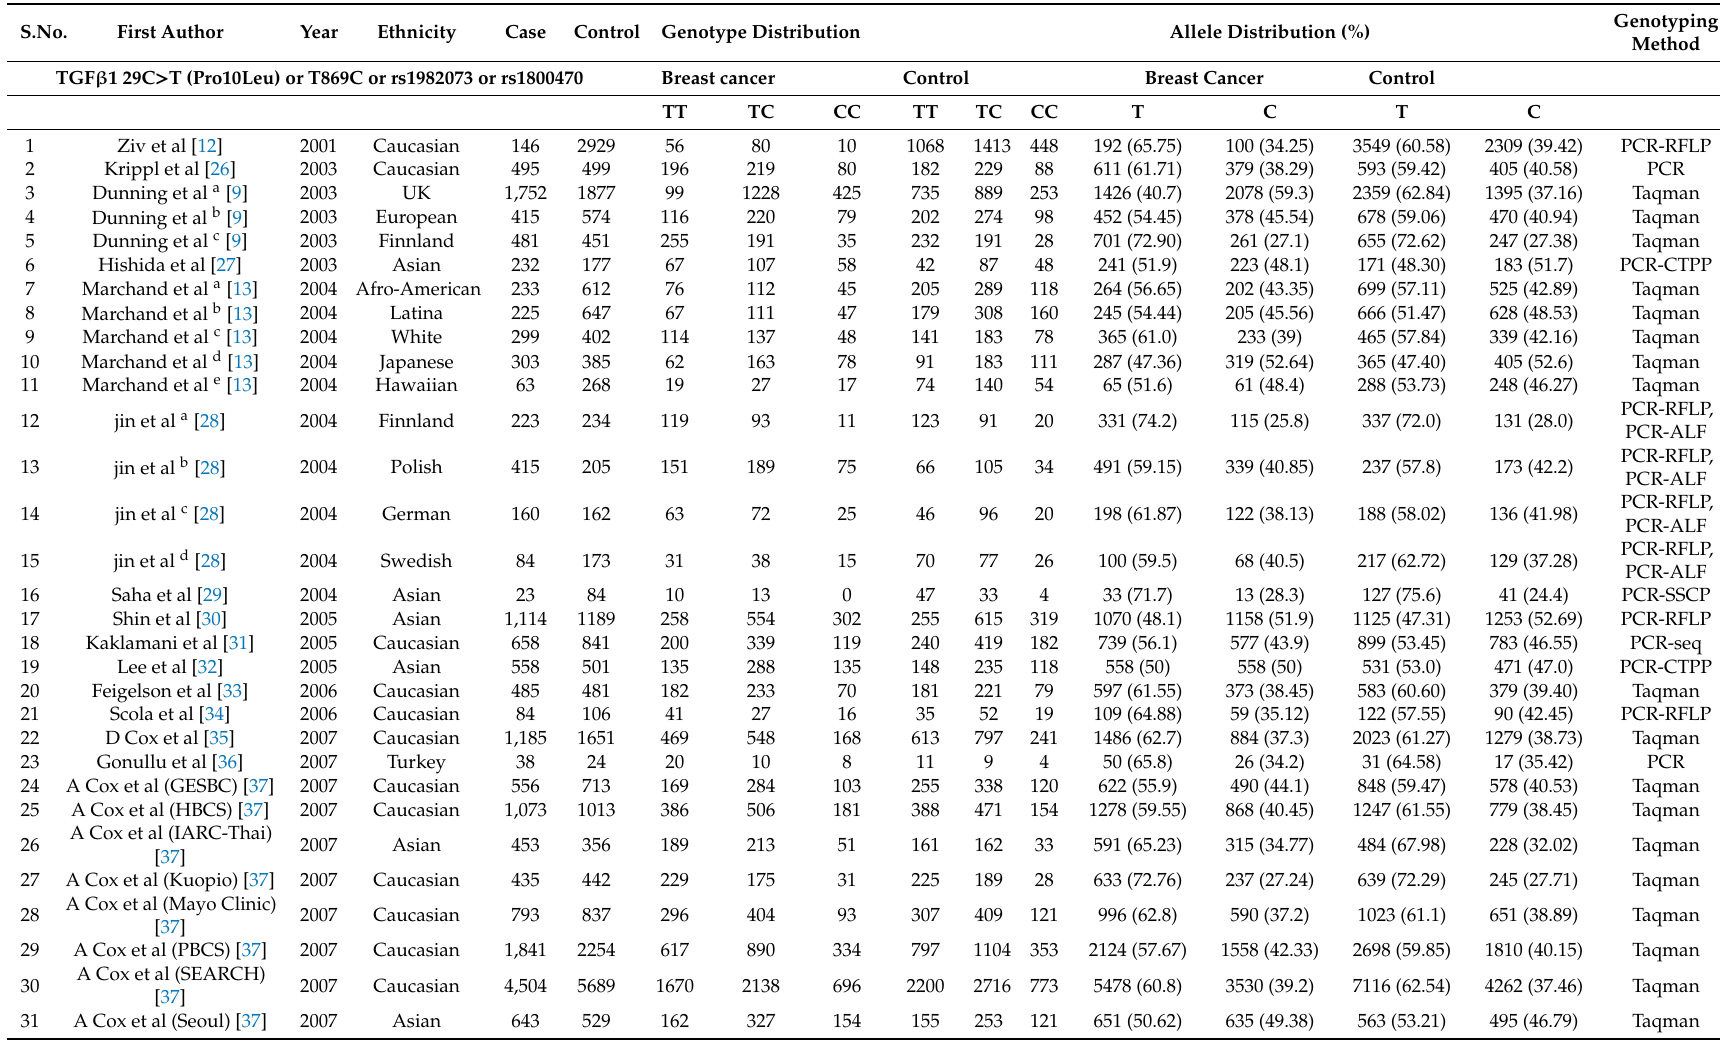
Table 1. Characteristics of all studies included for